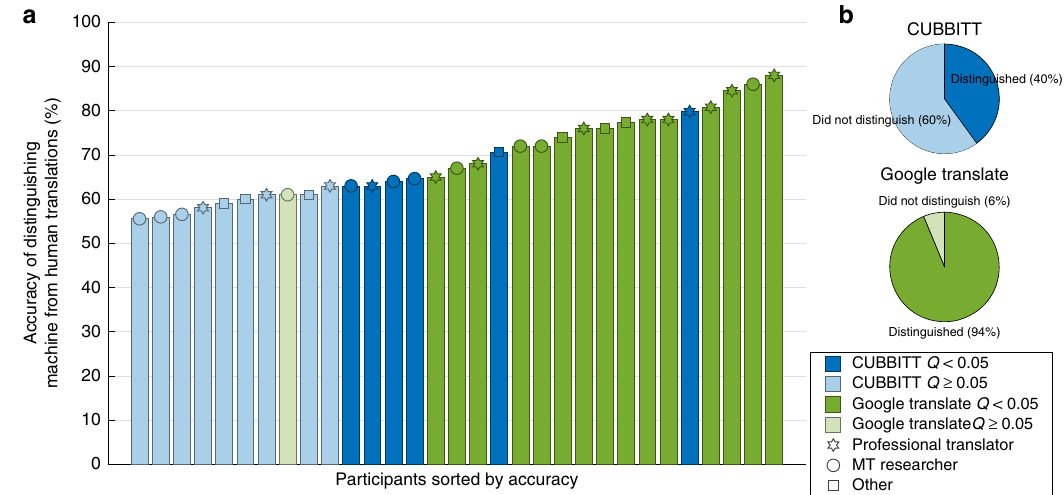
Participants sorted by Fig. 6 CUBBITT is dif fi cult to distinguish from professional human translator in a Translation Turing test. a Accuracy of individual participants in distinguishing machine from human translations is shown in a bar graph. Fisher test was used to assess whether the participant signi fi cantly distinguished human and machine translations and Benjamini – Hochberg method was used to correct for multiple testing. Participants with a Q value below 0.05 were considered to have signi fi cantly distinguished between human and machine translations. b Percentage of participants, who signi fi cantly distinguished human and machine translations for CUBBITT (top, blue) and for Google Translate (bottom,